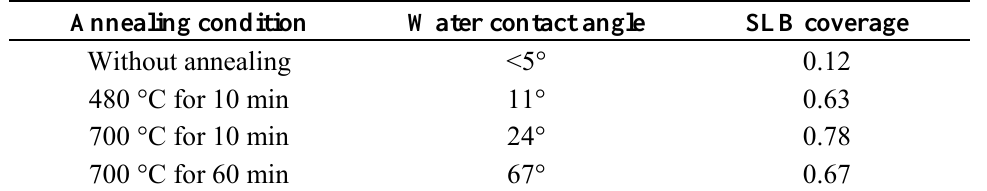
Table 1. Dependence of the efficiency of the SLB formation on the surface hydrophilicity controlled with the annealing conditions. All results from